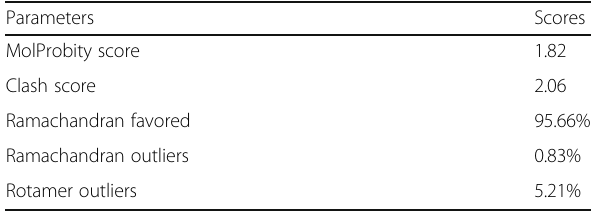
Table 2 The individual parameters and scores as calculated by